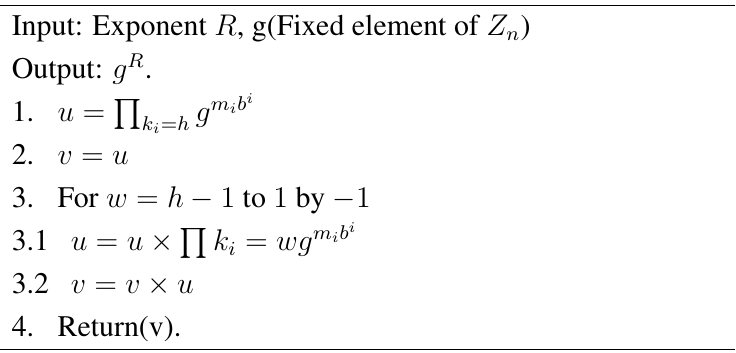
Algorithm 4. Lim and Lee’s method for